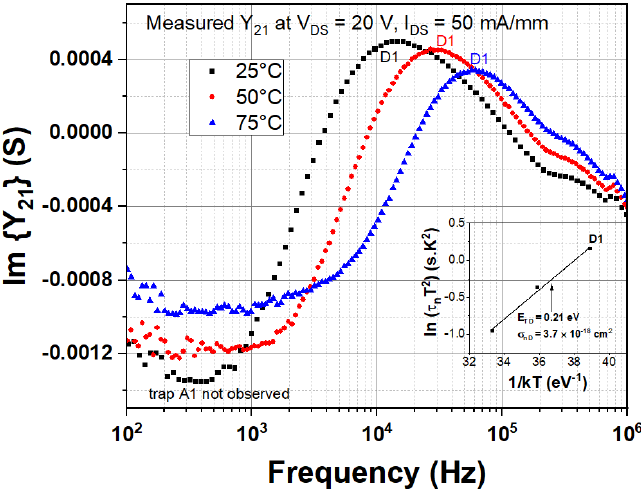
Figure 17. The measured LF Y 21 parameters obtained at V DS = 20 V, I DS = 50 mA/mm for various temperatures (25 to 75 °C) show only the surface donor at E C –0.21 eV. The buffer trap A1 is not detected for this bias condition.